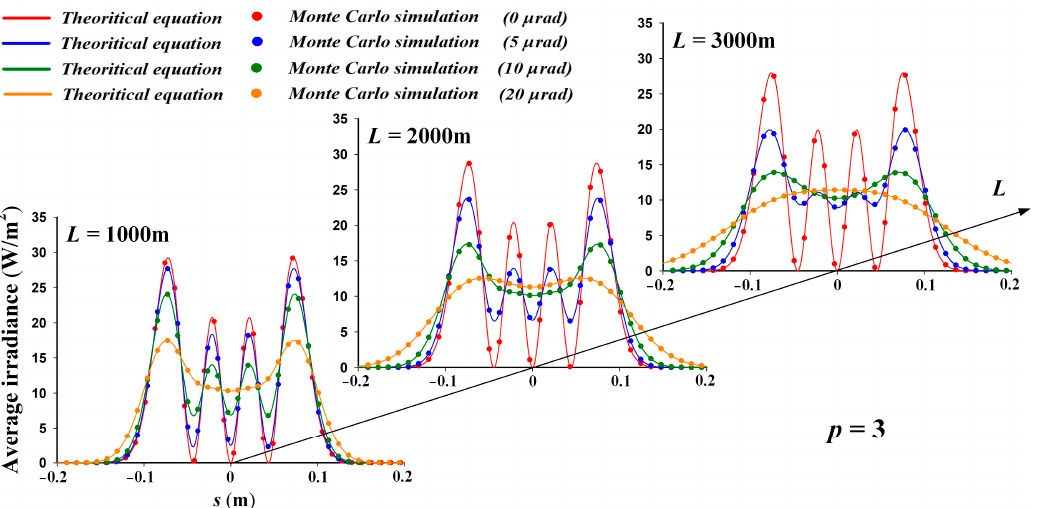
Figure 4. Average irradiance of HG beam under pointing error with the increase in propagation distance in the case of p = 3 .